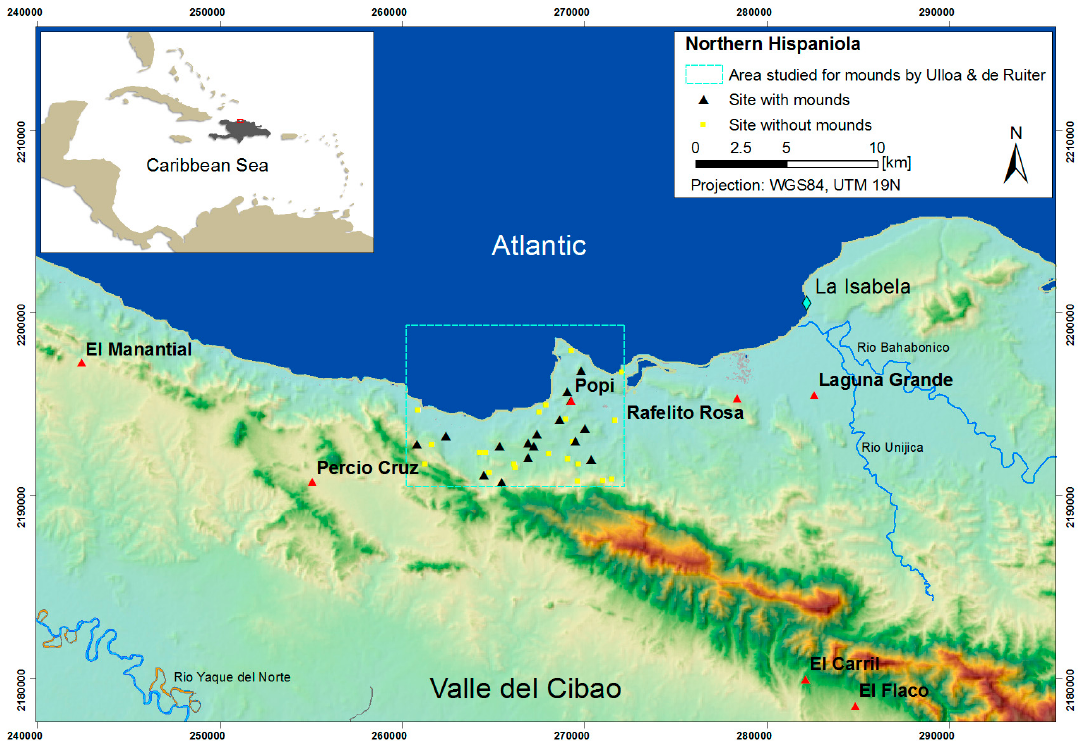
Figure 1. Regional overview of the northern Dominican Republic with an earlier study area to determine sites with mounds (black triangles) and without any (yellow triangles). Sites featured in the article are marked by red triangles.